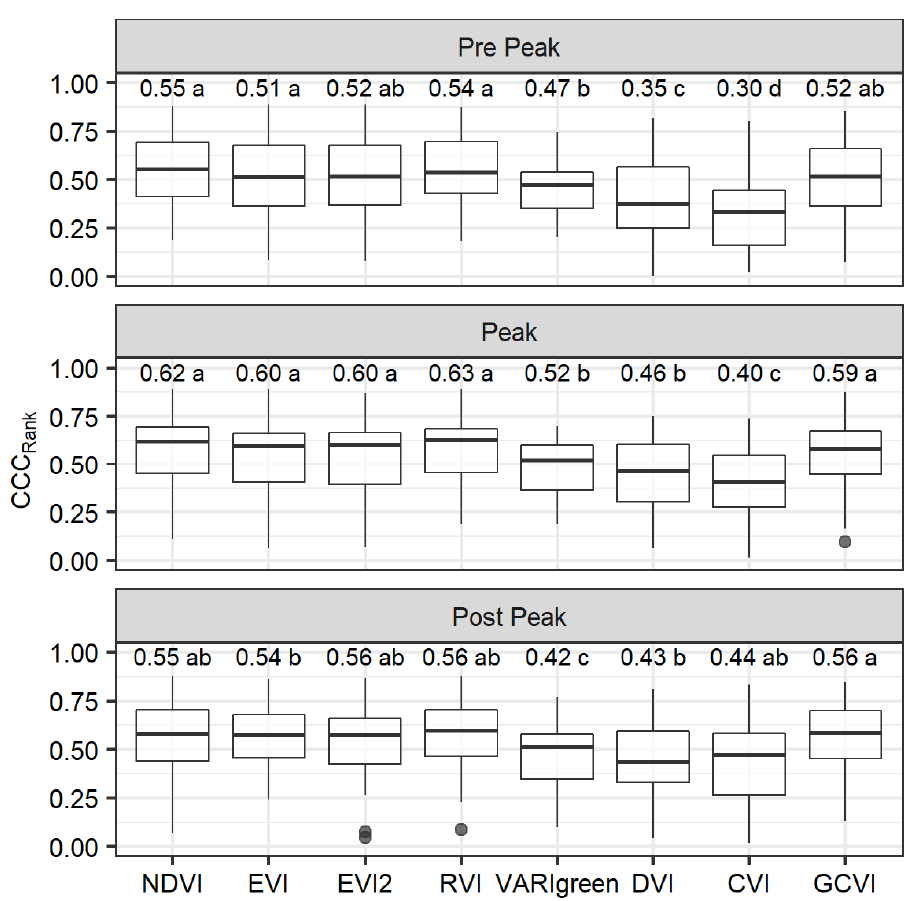
Figure 2. The concordance correlation coefficients of ranks for single vegetation indices from a single stage. Values show the median CCC Rank for each treatment. For better visualisation, the figure excluded negative CCC Rank . Within a stage, vegetation indices with the same letters are not significantly different. Table 3. Median CCC values from cross-validation based on manually selected covariates and those from the stepwise analysis. Covariates for stepwise models are referred to as S1–S5.